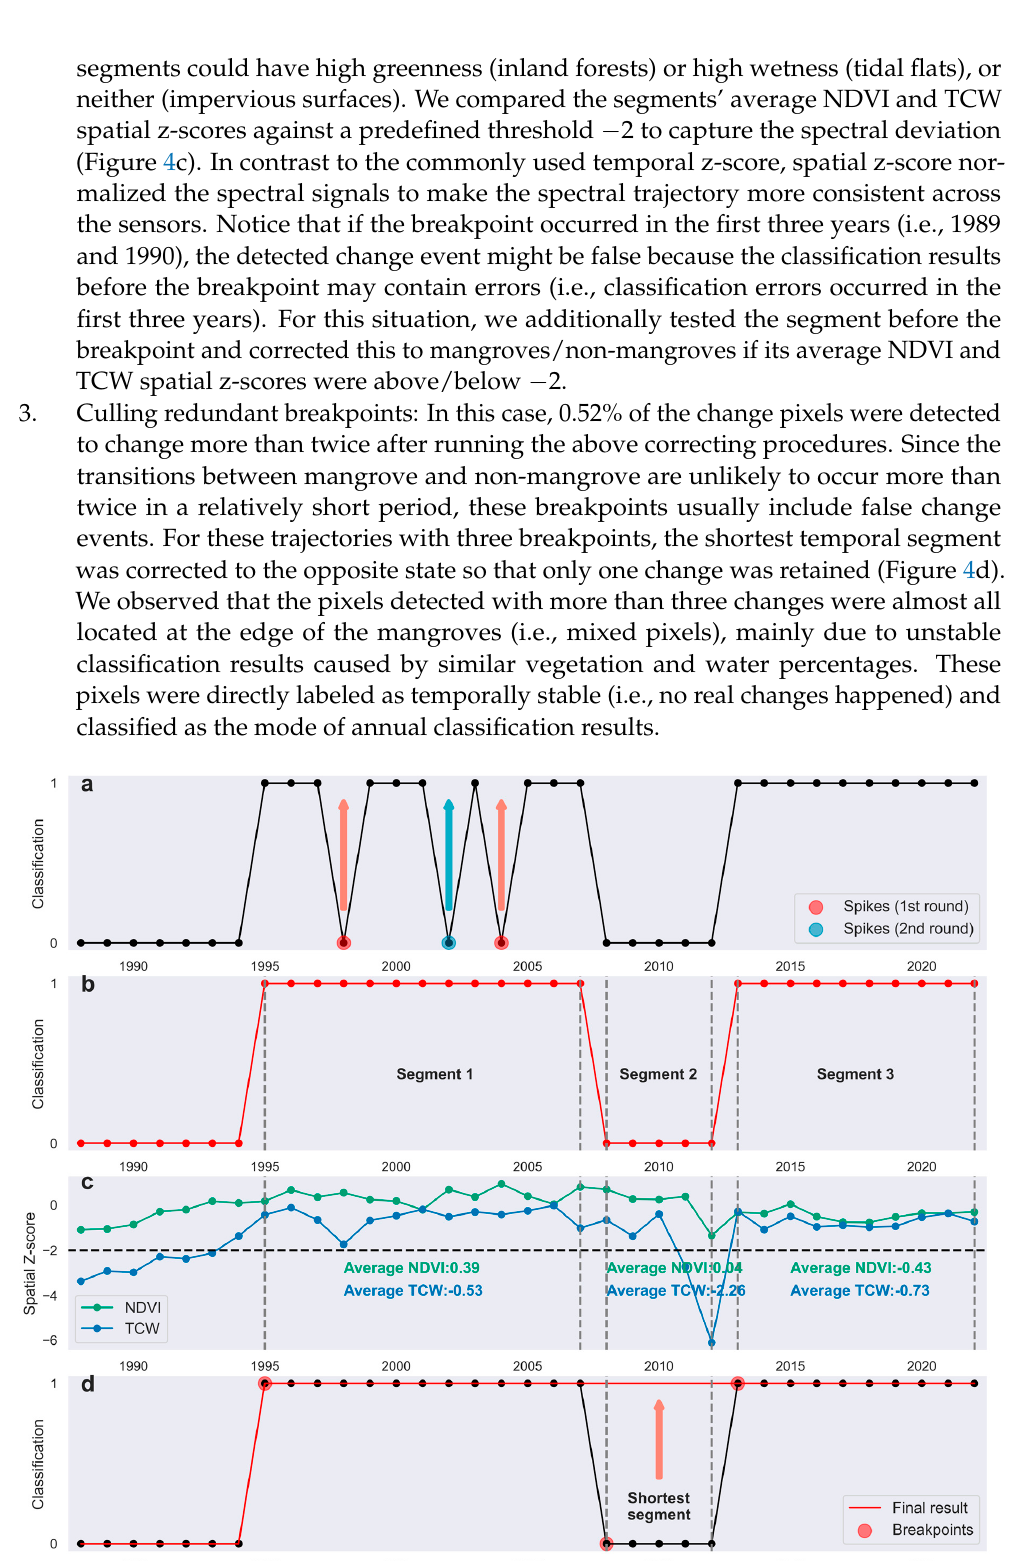
Figure 5. ( a ) NDVI and ( b ) TCW of five land-cover types. Boxes represent data within the 25th and 75th percentile, red lines show medians, and whiskers show 1.5× the interquartile range. Data points beyond that range (outliers) are shown as dots. Indices were collected from the Landsat-8 median composite in 2022.